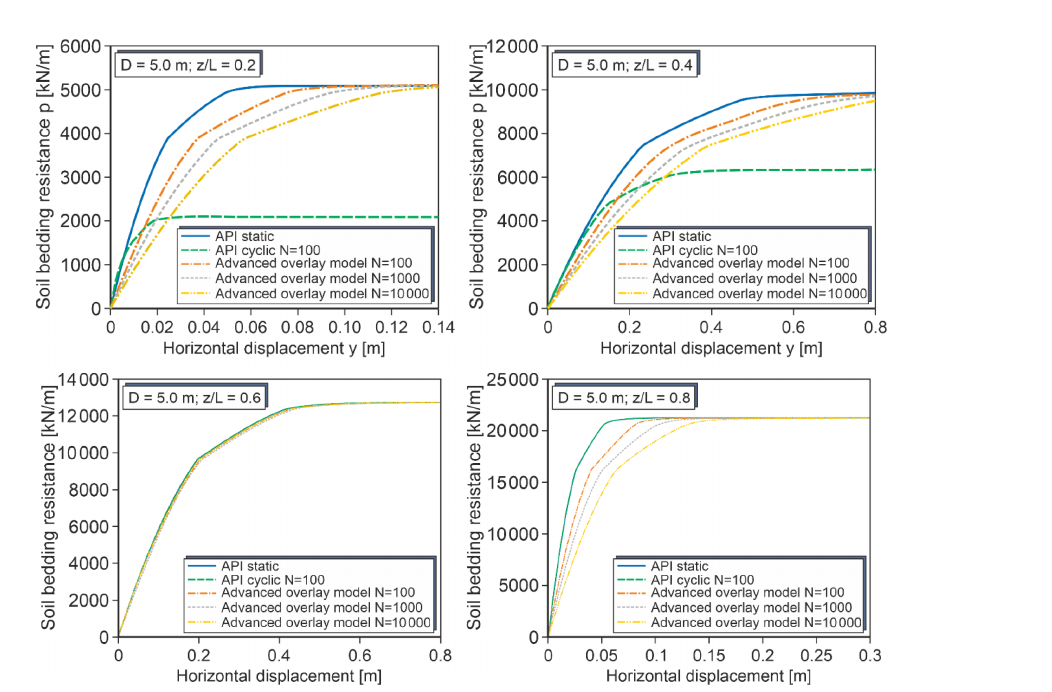
Figure 15. Comparison of cyclic p – y